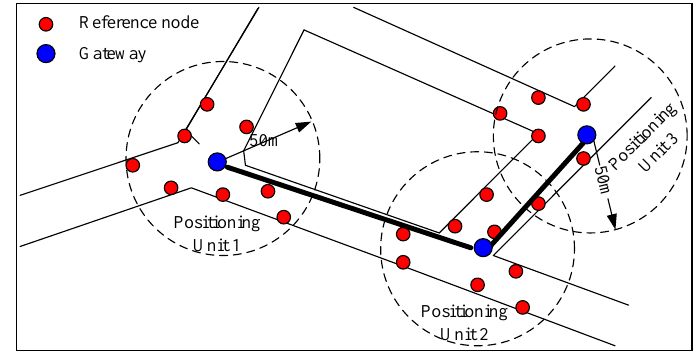
Figure 3. The deployment of reference nodes in each local positioning